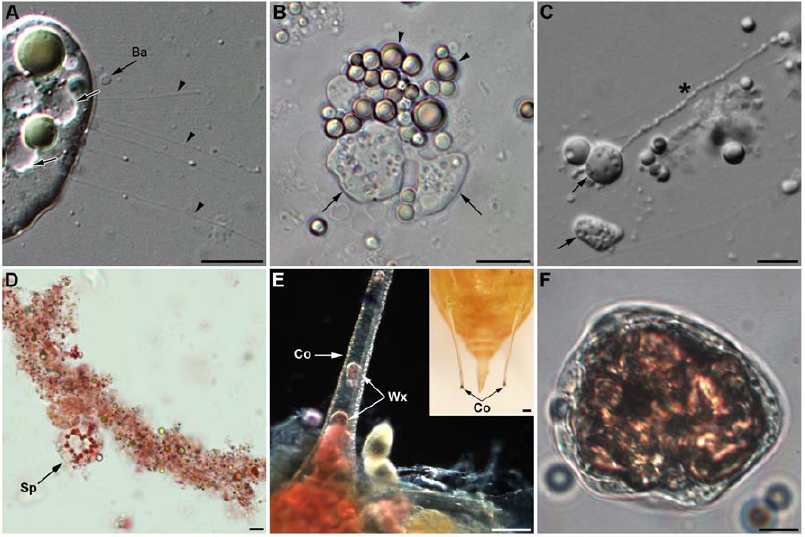
Figure 4. Functions of spherulocytes and wax cells. (A–C) Early alterations of spherulocytes after hemolymph collection: (A) loss of spherules and fibrils’ formation (arrowhead). Ba : B. aphidicola . (B) Unstable cytoplasmic blebs (arrow) derive from spherulocytes while spherules remain intact (arrowhead). (C) From blebs (arrow), long stable strands like strings of pearls extend (asterisk; see also movie 1). (D) Low magnification of a large coagulum stained by neutral red showing a granular aspect and the presence of an intact spherulocyte ( Sp ). (E–F) Wax cells ( Wx ) are localized at the base and inside the cornicles ( Co ), secretory appendices localized at the posterior end of aphids’ bodies (inset in (E)). (E) Red lipid staining showing large accumulation of lipid-containing cells at the base of the cornicle. (F) Wax cell containing a large neutral lipidic inclusion (pink staining) that